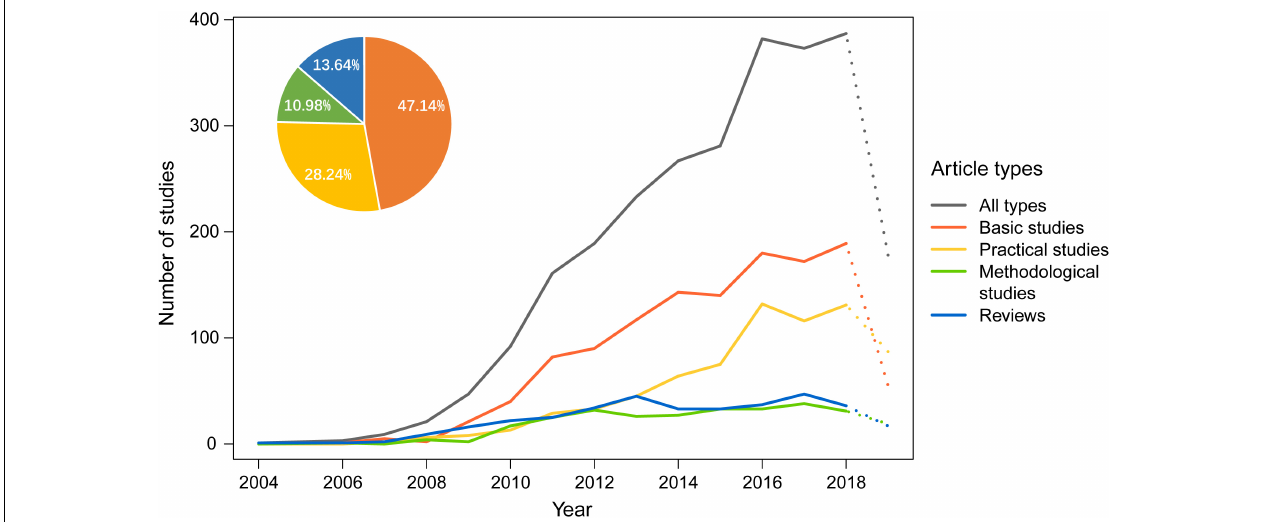
FIGURE 4 | The number of different types of articles on DNA barcoding published by Chinese scientists each year. The X axis represents the year of publication, and the Y axis represents the number of studies. A complete dataset for 2019 is not yet available and is shown as a dotted line. The pie chart at the top left represents the proportion of the total number of research articles of each type derived over 16